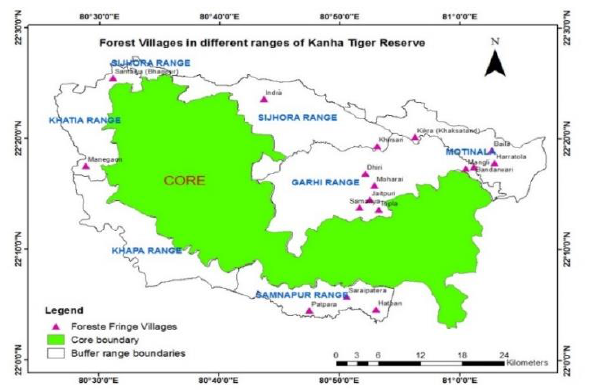
Fig. 1 Map of Kanha Tiger Reserve showing different ranges and forest